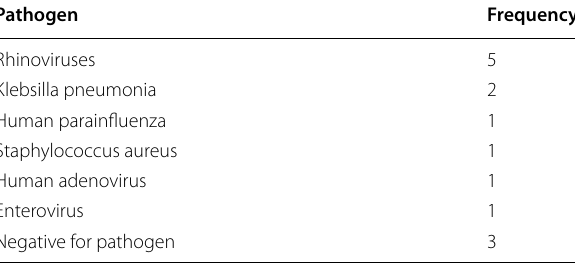
Table 4 Results of PCR testing for negative COVID-19 patients